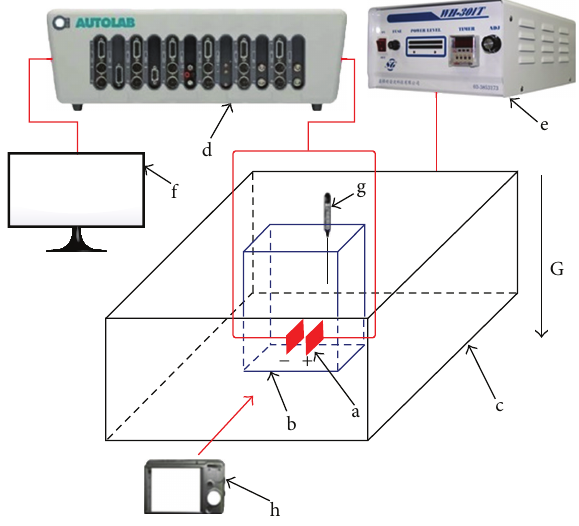
Figure 1: The experiment devices. (a) Electrodes, (b) electrolysis cell, (c) outer cell, (d) potentiostat, (e) ultrasonic generator, (f) computer, (g) thermometer, and (h)